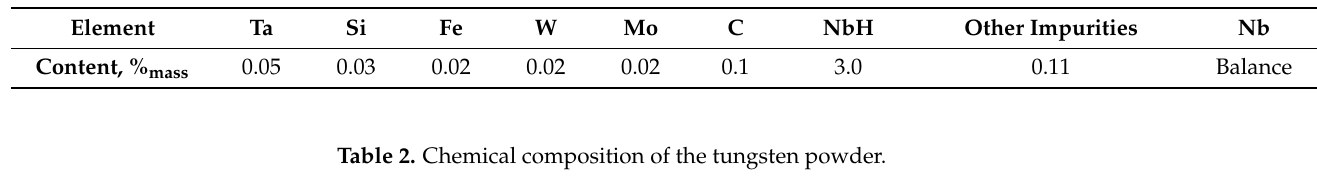
Table 1. Chemical composition of the niobium powder.